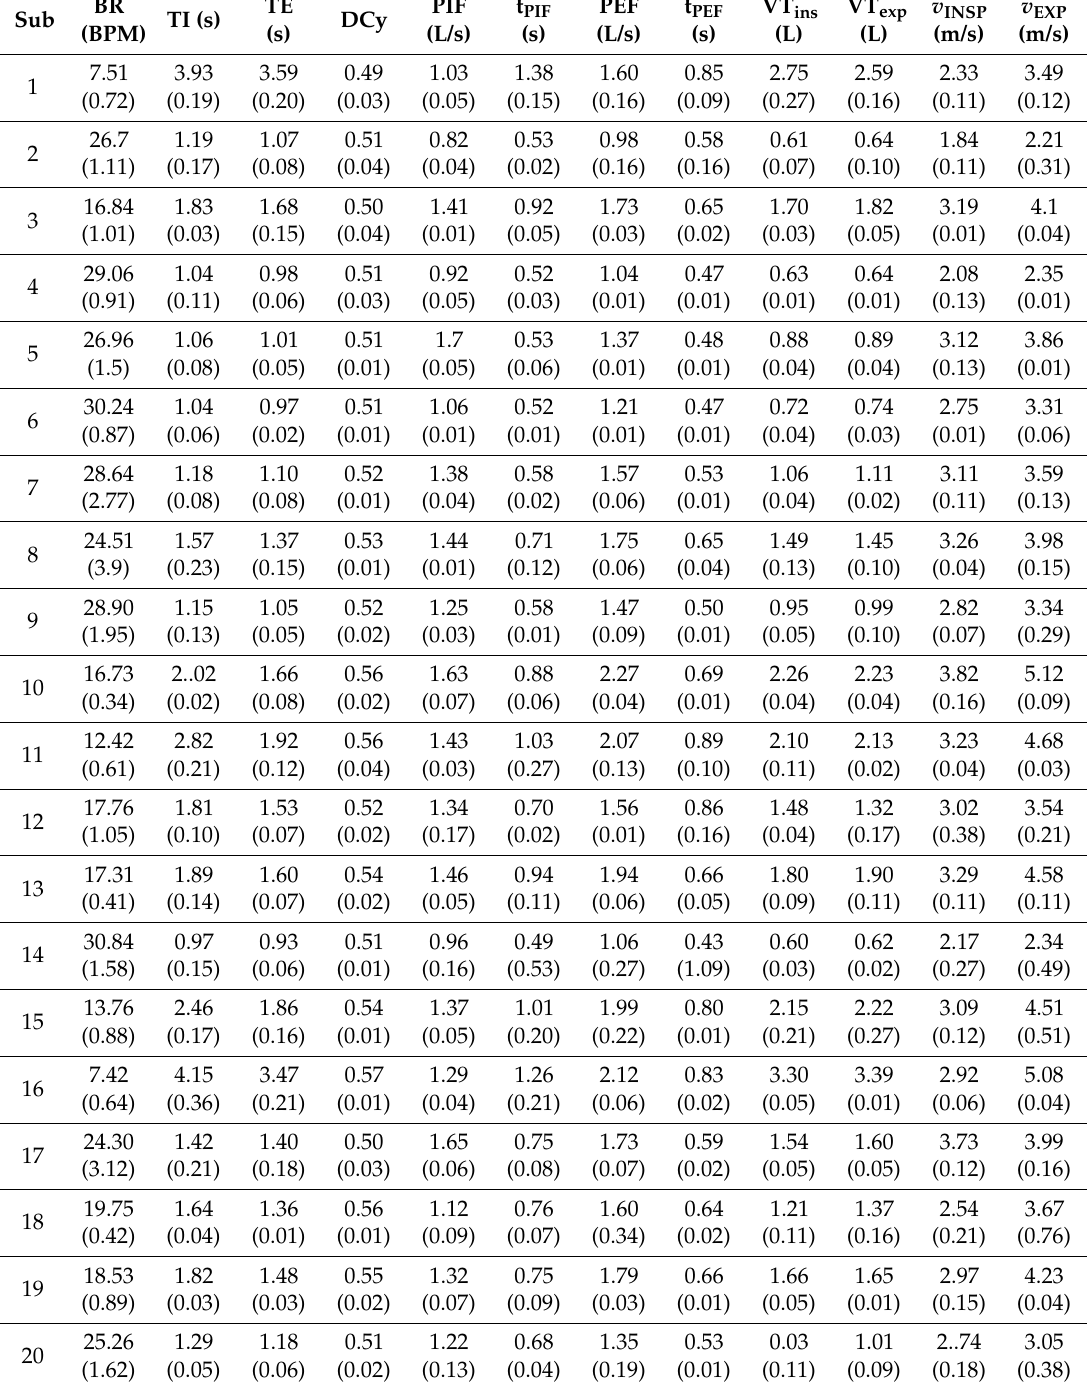
Table 4. Attributes computed from TBP flow and TBP volume for all twenty subjects. BR: breathing rate; TI: inspiration time; TE: expiration time; DCy: duty cycle; BPM: breaths cycles per minute; VT ins